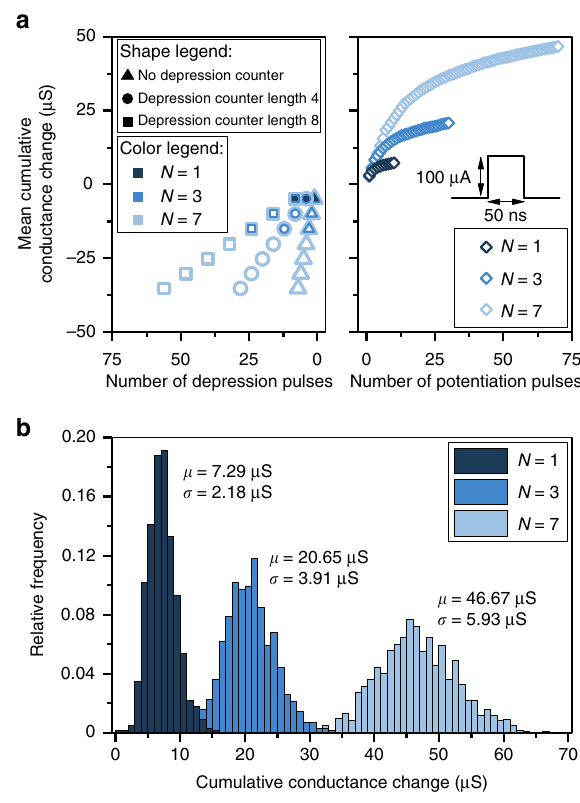
Fig. 3 Multi-memristive synapses based on phase change memory. a The mean cumulative conductance change is experimentally obtained for synapses comprising 1, 3, and 7 PCM devices. The measurements are based on 1000 synapses, whereby each individual device is initialized to a conductance of ∼ 5 μ S. For potentiation, a programming pulse of I prog = 100 μ A was used, whereas for depression, a programming pulse of I μ A was used. For depression, the conductance response can be made more symmetric by adjusting the length of the depression counter. b Distribution of the cumulative conductance change after the application of 10, 30, and 70 potentiation pulses to 1, 3, and 7 PCM synapses, respectively. The mean ( μ ) and the variance ( σ 2 ) scale almost linearly with the number of devices per synapse, leading to an improved weight update